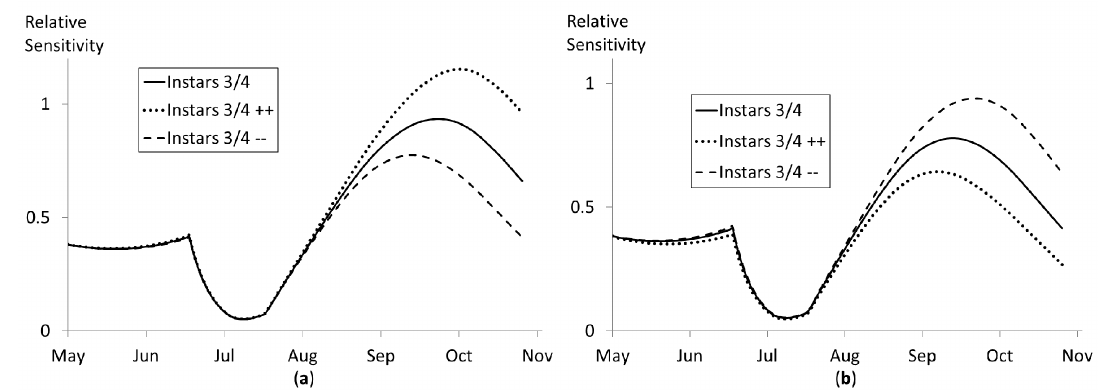
Figure 16. Results of the global sensitivity analysis when increasing (++) or decreasing (--) the initial biomass concentration of ( a ) Cladocera or ( b ) fathead minnow.